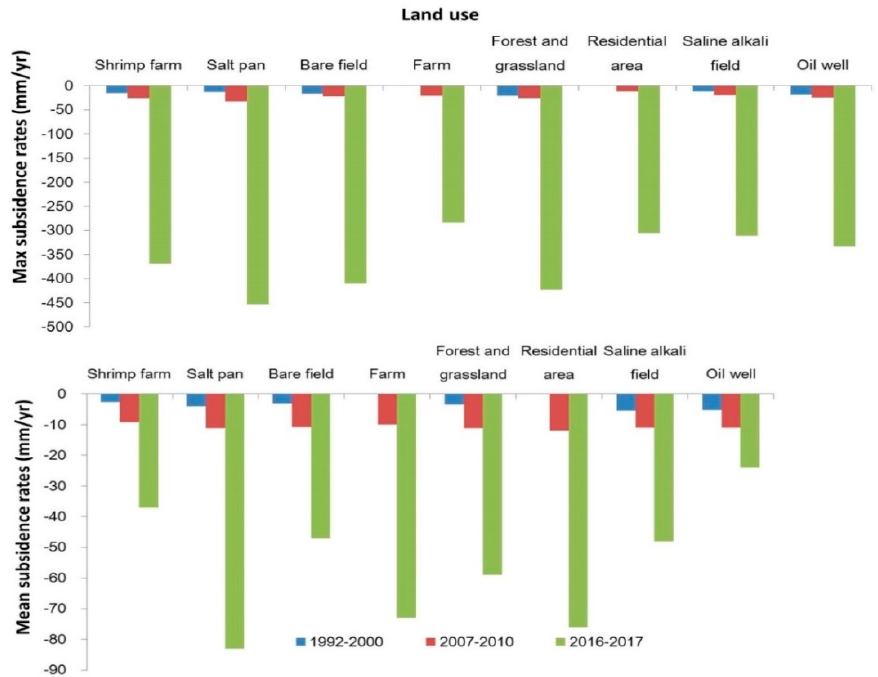
Figure 6. Statistics of the subsidence for unchanged land-use types from P1 (1992–2000) and P2 (2007–2010) to P3 (2016–2017). The category shown in Figure 6 comprises the constant land-use sequences during both periods (P1, P2, and P3). After the slow growth of the first two periods (P1 and P2), the subsidence rate of the land-use class exhibited explosive growth in P3. The highest subsidence rates occurred for salt pans, which increased from 13 mm/year (P1) and 32 mm/year (P2) to 453 mm/year (P3). The lowest subsidence rates were observed for bare land, which increased from 16 to 22 mm/year in the two periods. The average land subsidence rate varied from 3–5 mm/year (P1) and 9–12 mm/year (P2) to 24–83 mm/year (P3). The standard deviation was less than 7